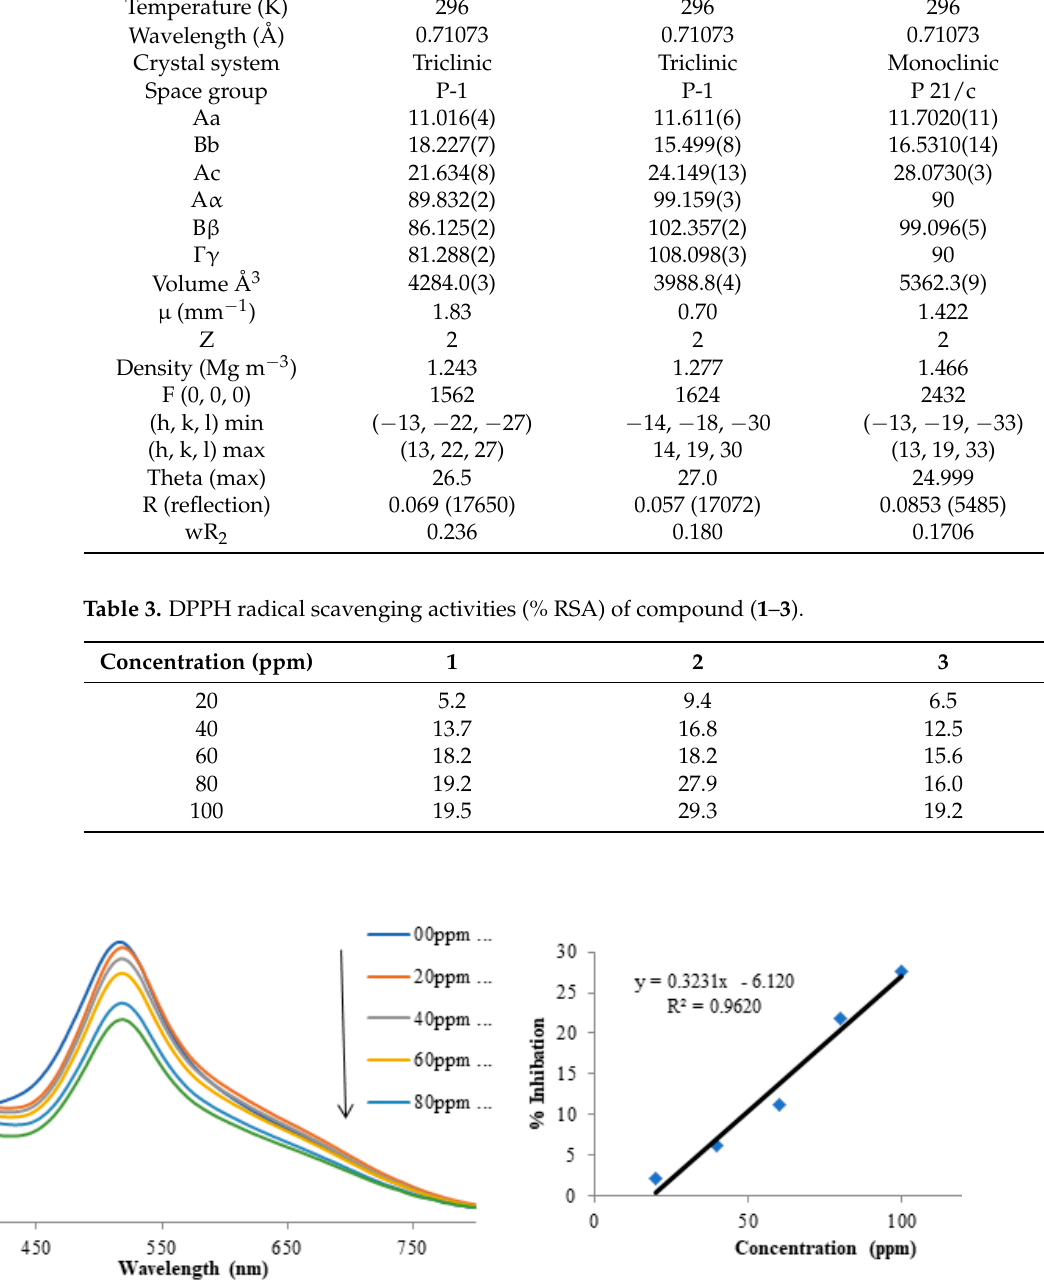
Figure 13. Absorption spectra of compound 1 . Arrow shows the decreasing change in absorption spectra of the compound/DPPH mixture on increasing concentration of the compound ( left ). Graphical representation of % Inhibition versus concentration of compound 1 for radical scavenging activity ( right ).